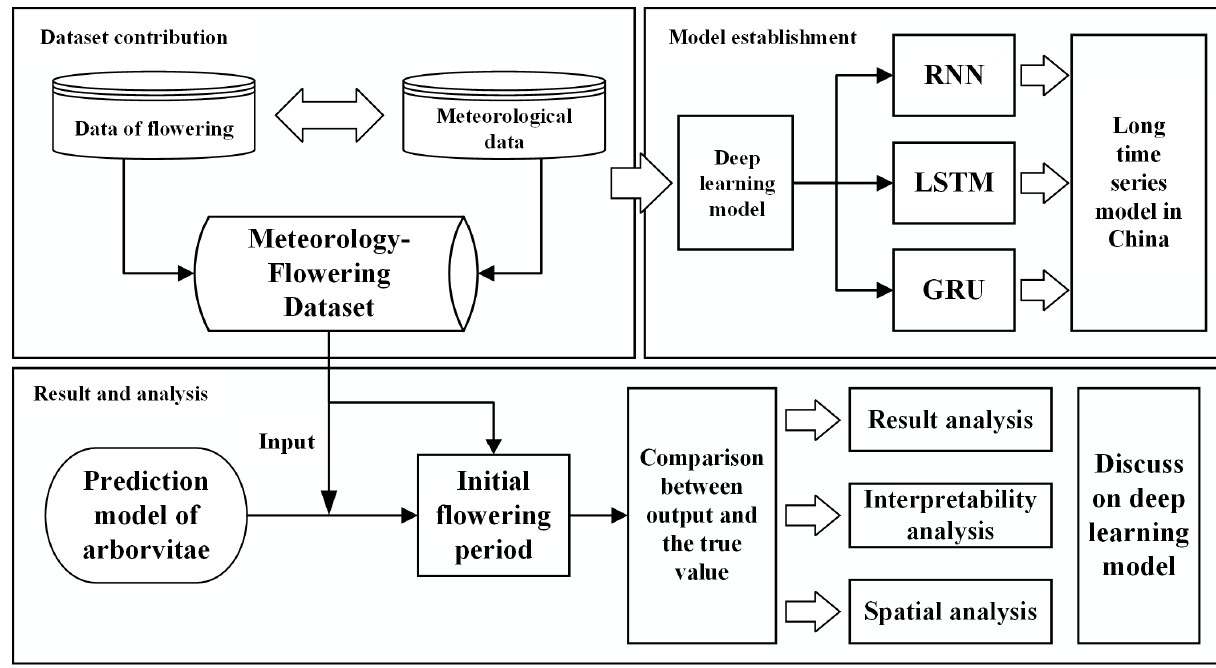
Figure 3. Flow figure of establishing DL models.